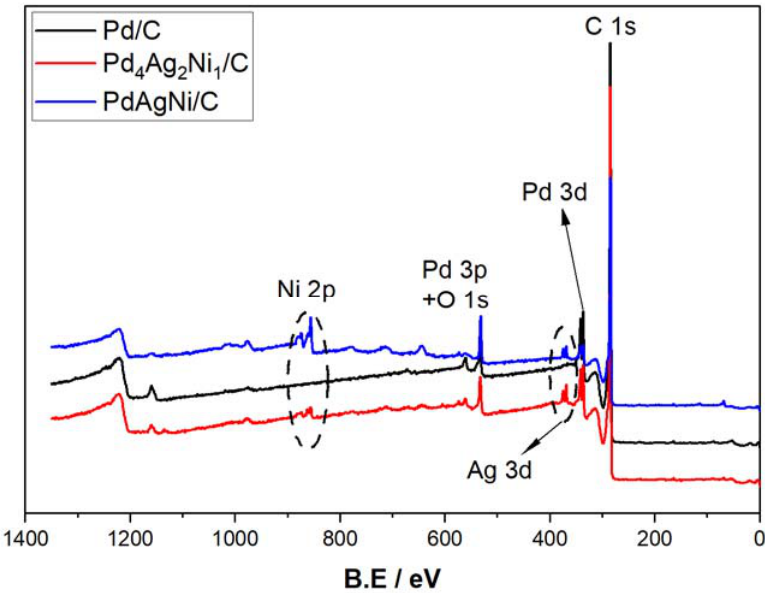
Figure 4. XPS full surveys of Pd/C, Pd 4 Ag 2 Ni 1 /C, and PdAgNi/C.